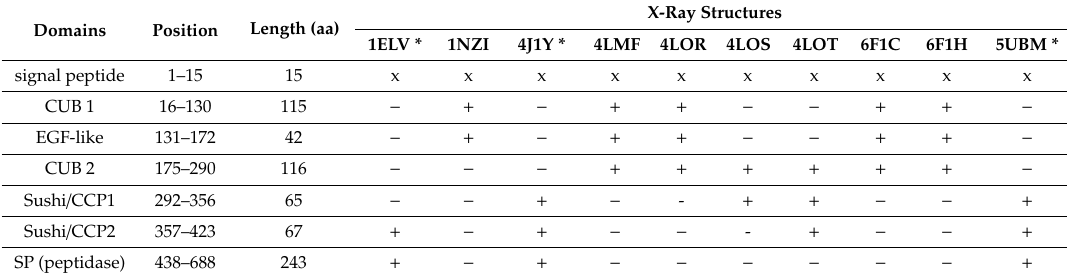
Table 12. Published protein C1s X-ray crystallography structures and their domain